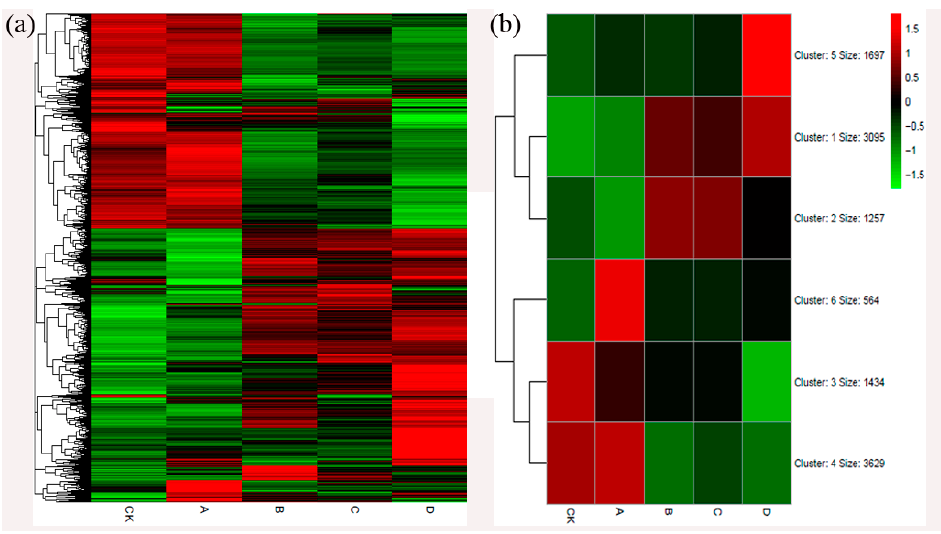
Figure 4. Heat maps of differentially expressed genes (DEGs). ( a ) Heat maps of DEGs; ( b ) Cluster analysis of DEGs.